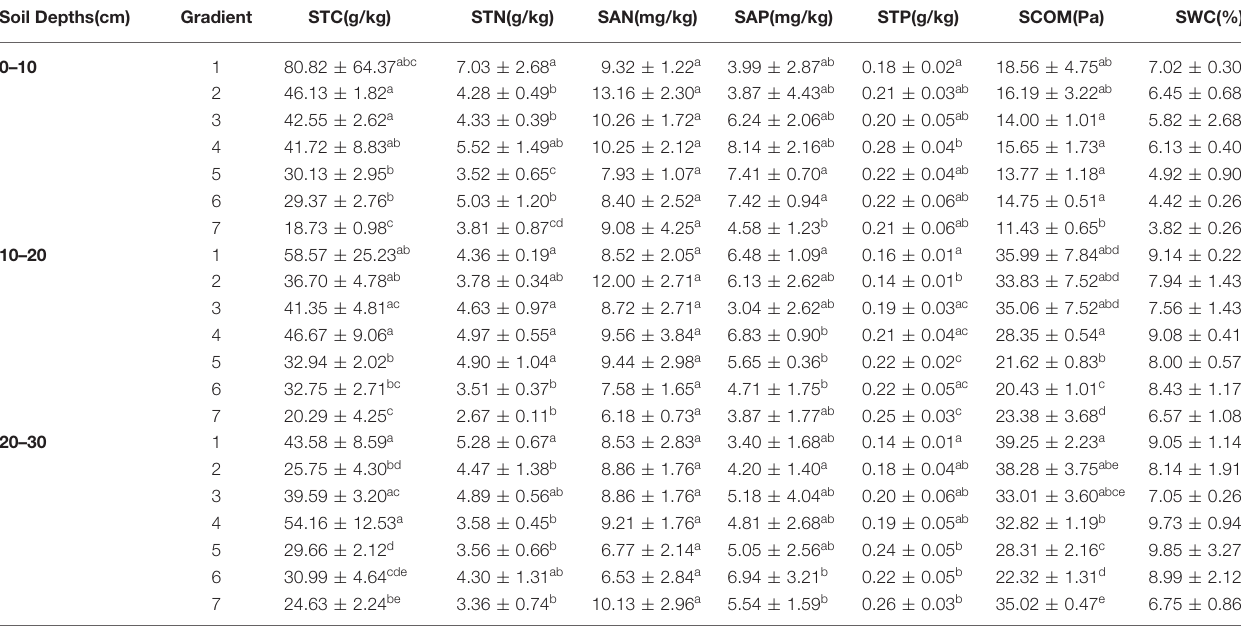
TABLE 2 | Soil properties along the degraded gradient of alpine steppe (mean ± s.e.). Soil